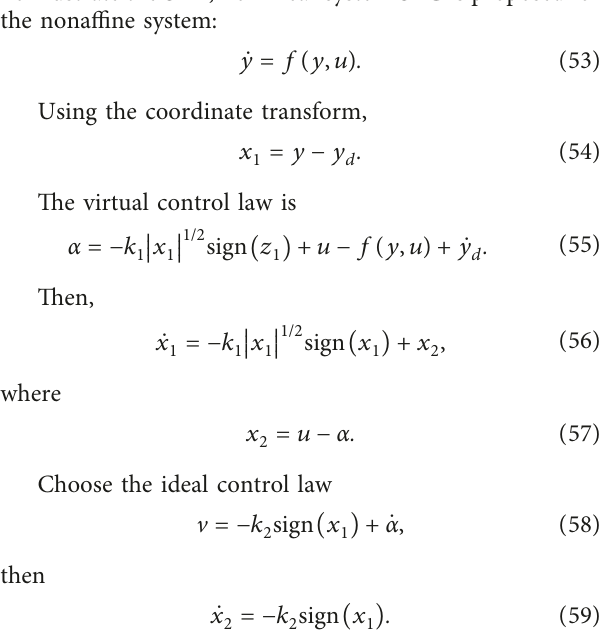
Figure 4. Secondly, t Figure 5. Finally, the reaching time t � t a Figure